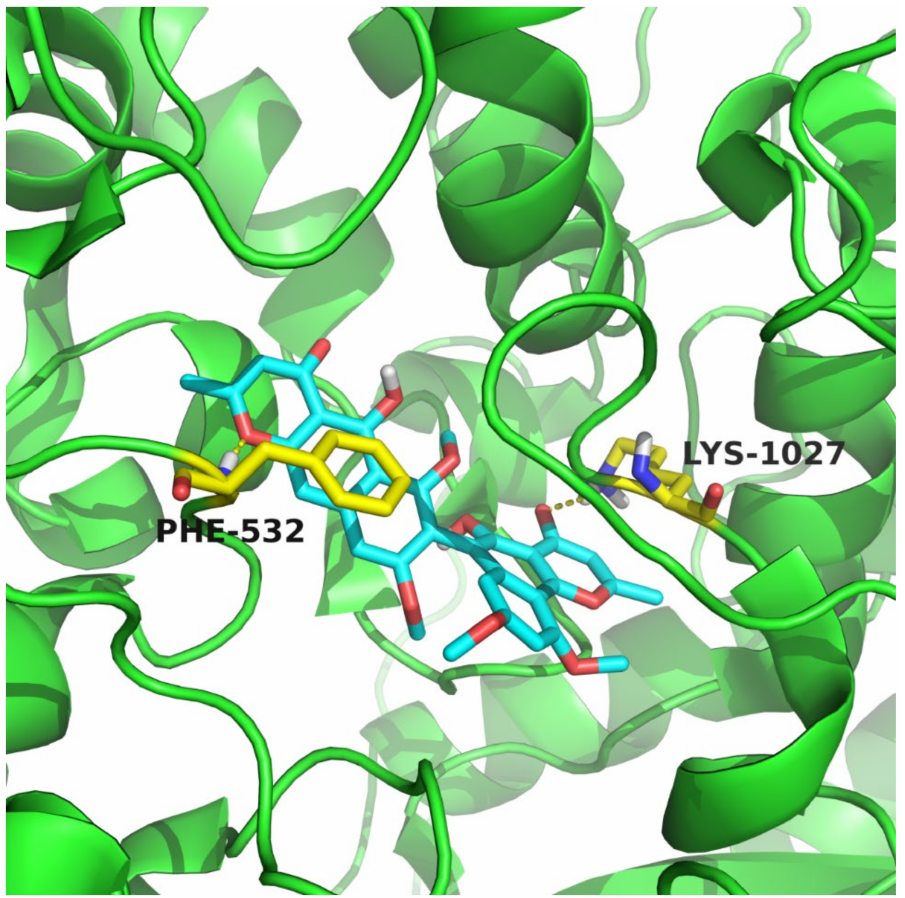
Figure 3. The binding mode of compound 4 with NPC1L1. Compound 4 was shown in cyan. The figure was produced with PyMOL. The related amino acids were shown in